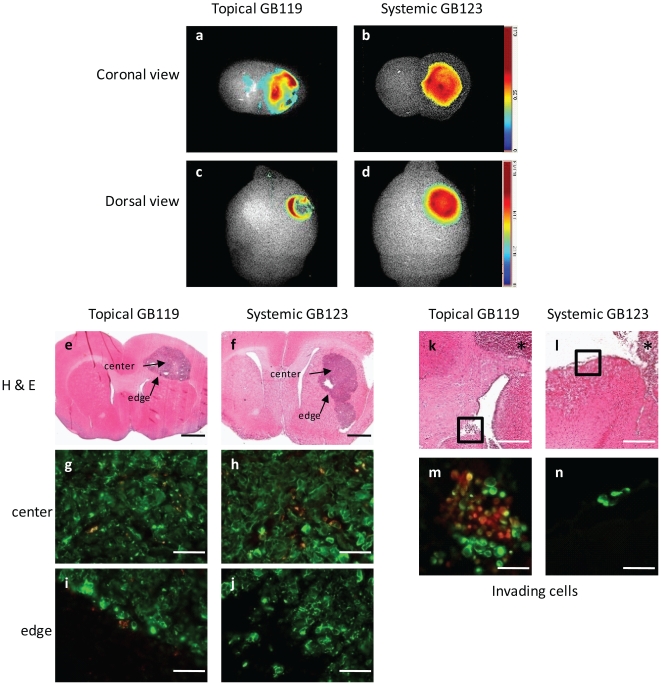
Comparison of tumor cell labeling between topical application of GB119 and systemic administration of GB123.(a–d) Representative unmixed false colored maps of pixel intensity of coronal 2 mm sections (a,b) and dorsal surface tumors (c,d) comparing the pattern of activation of topical GB119 (left side) and systemic GB123 (right side). (e,f) H&E coronal sections demonstrating tumor mass. (g–j) Merged fluorescent microscopy of adjacent sections showing labeling in the center (g,h) and edge (I,j) of the tumor. Sections were immunostained with anti-human vimentin antibody to reveal the brain tumor xenograft (false colored green), covalently bound Cy5 (false colored red). Yellow represents co-localized staining. (k & i) H&E sections demonstrating tumor cells that migrated away from the main tumor mass (outlined) via the ventricular system (k) or along the cortical meninges (i). Boxed regions indicate invading cells (m & n). Merged images of boxed regions from panels k & i showing labeling of invading tumor cells. Vimentin positive tumor cells (false colored green) and Cy5 cells (false colored red) reveals that invading cells were identified by topical GB119 (yellow cells) (m) but not by systemic GB123 (n). DAPI staining for cellular orientation was also included in panels m,n. Scale bar, 1 mm (e,f), 500 µm (k,l), and 50 µm (g–j, m, n).